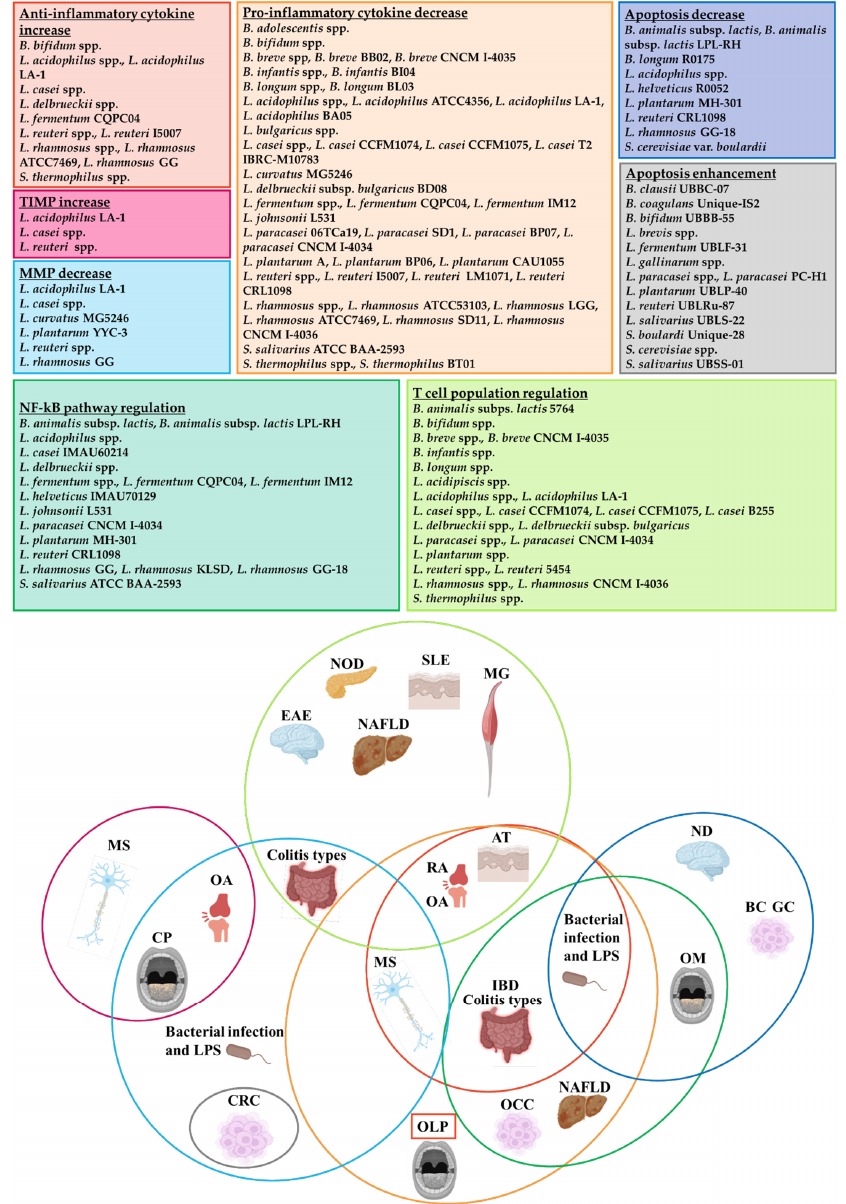
Figure 2. Impact of probiotics on inflammatory and apoptotic pathways and T cell population